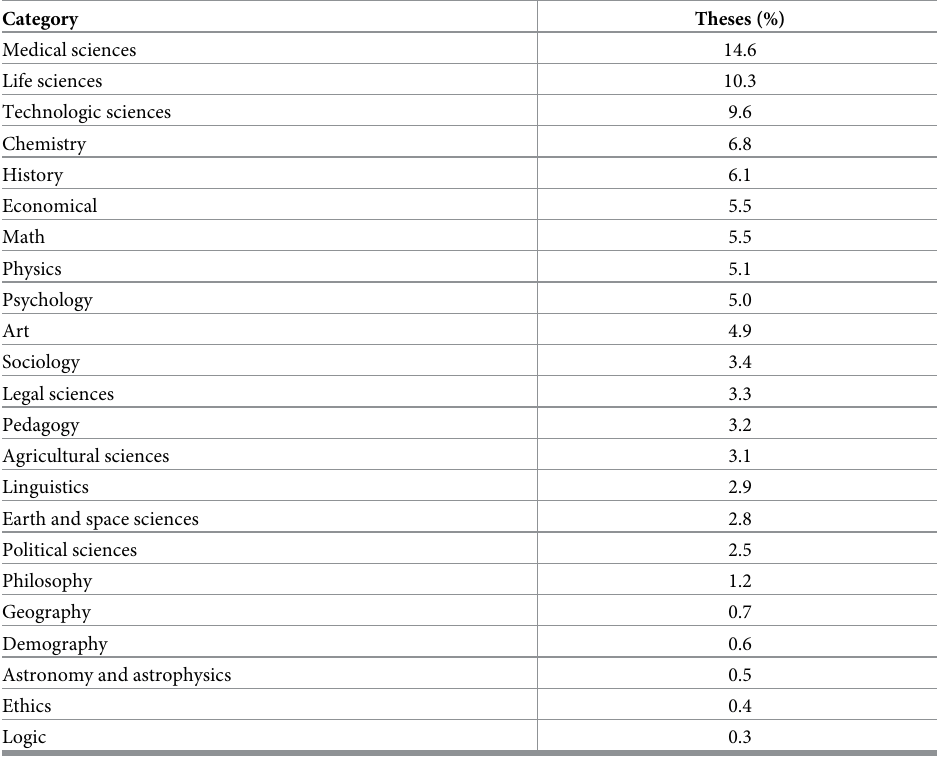
Table 3. Categorization of doctoral